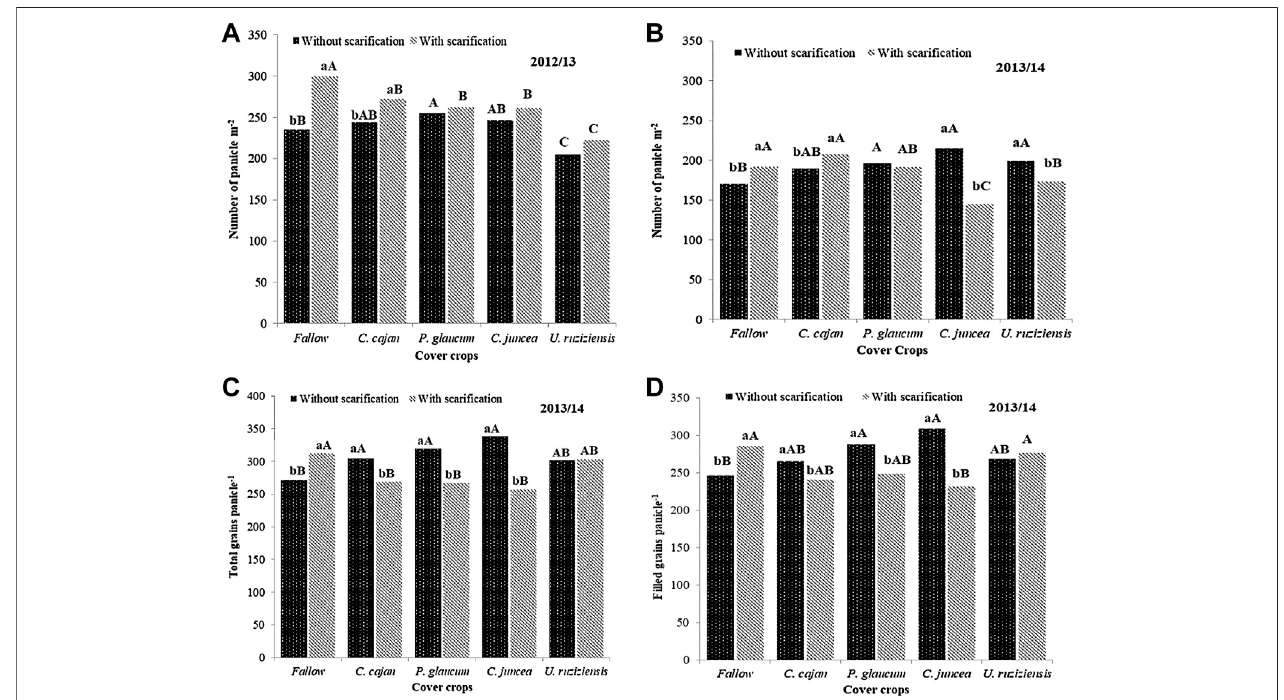
FIGURE 2 | Effect of mechanical soil scari fi cation (MS) and cover crops (CC) in no-tillage system on number of panicles m − 2 of upland rice in 2012/2013 (A) and 2013/2014 (B) , total number of grains panicle − 1 in 2013/2014 (C) and number of fi lled grains panicle − 1 in 2013/2014 (D) . Means followed by same lowercase letter for CC within MS and uppercase for MS within CC were statistically not different by Tukey test at 5% probability.